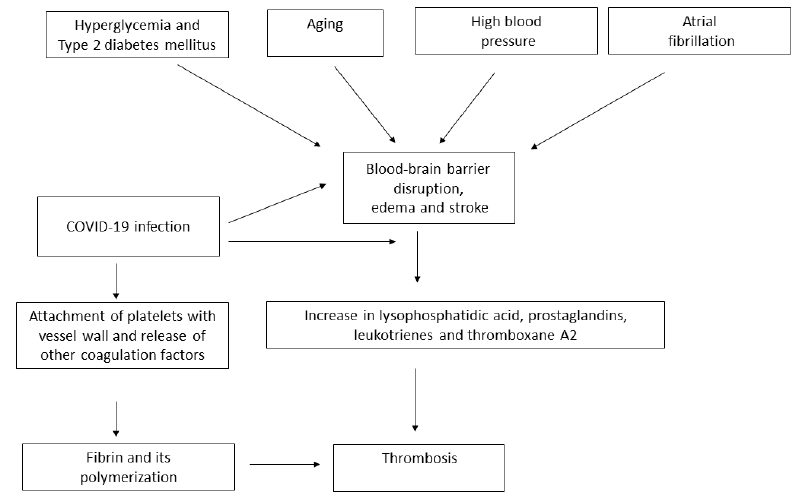
Figure 3. Risk factors for stroke.